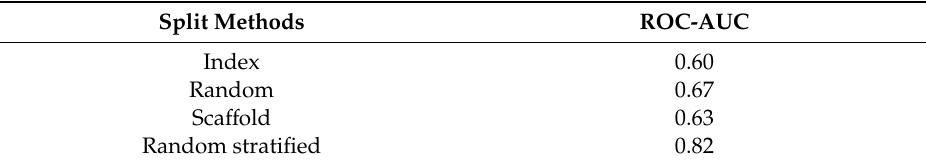
Table 3. The ROC-AUC performance of the split